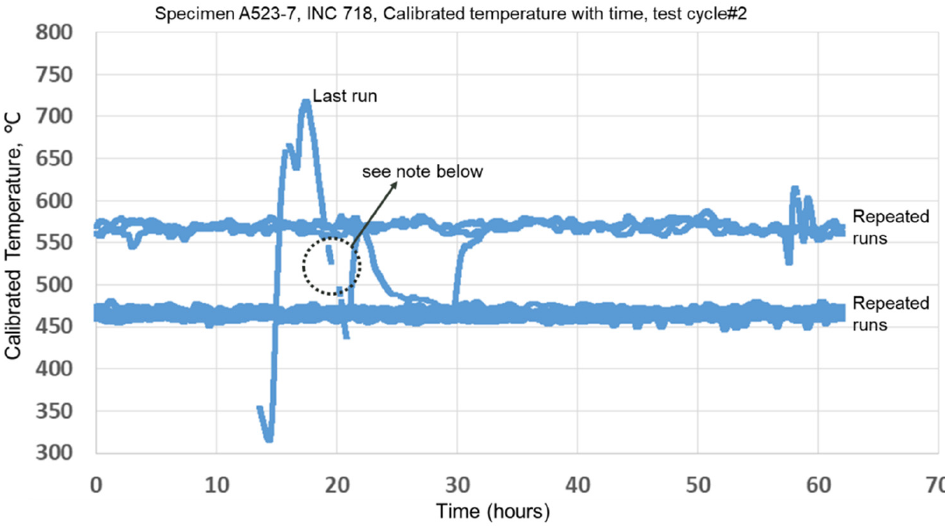
Figure 17. Calibrated temperature measurement using embedded FBG sensor on INC 718 specimen A523-7 (test cycle#2). (Note: loss of data caused by impaired signal strength, which in turn shows that the FBGs start to erase).